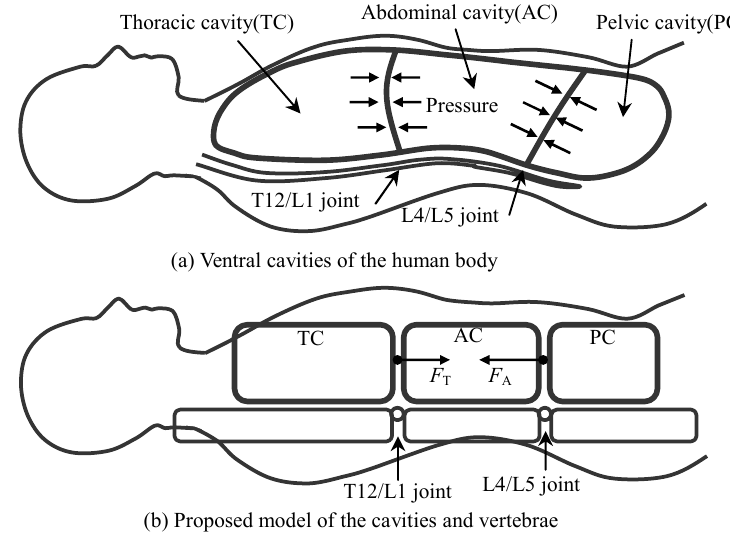
Fig. 2 Schematic illustrations of pressures around abdominal regions and modeling of the ventral